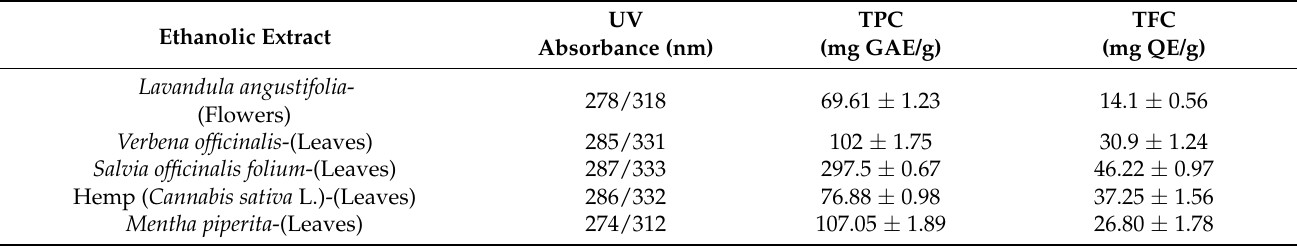
Table 1. The total of phenols and flavonoids content and UV spectra from leaves and flowers of studied